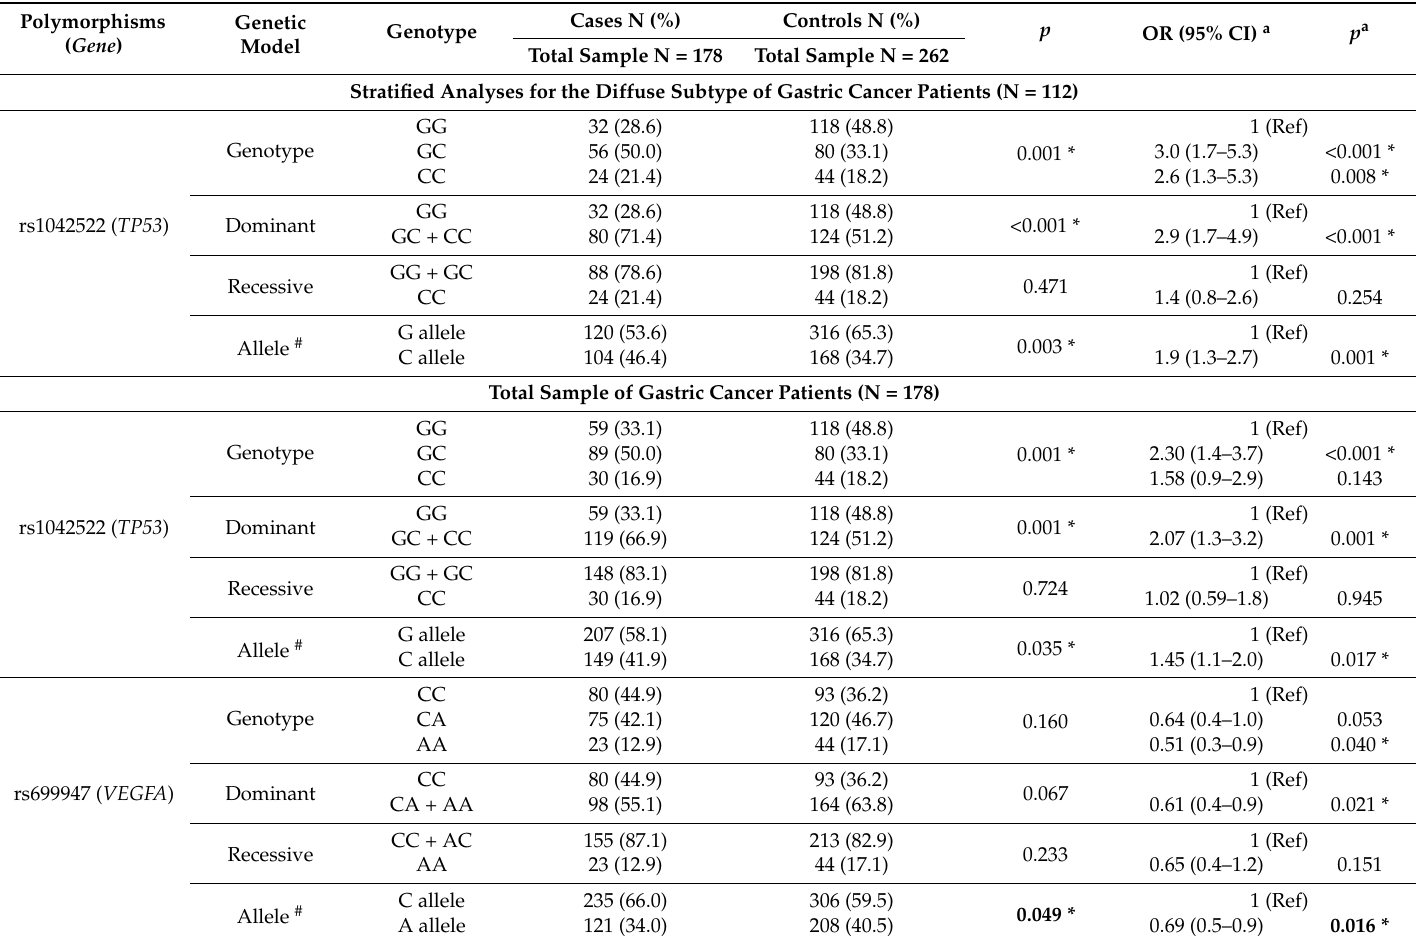
Table 2. Results of the significant associations detected between rs1042522 ( TP53 ) and rs699947 ( VEGFA ) with gastric cancer (both in the cases stratified for the diffuse histological subtype and in the total sample) and the Odds Ratio calculation after adjustments for the covariates in the multivariate logistic regression